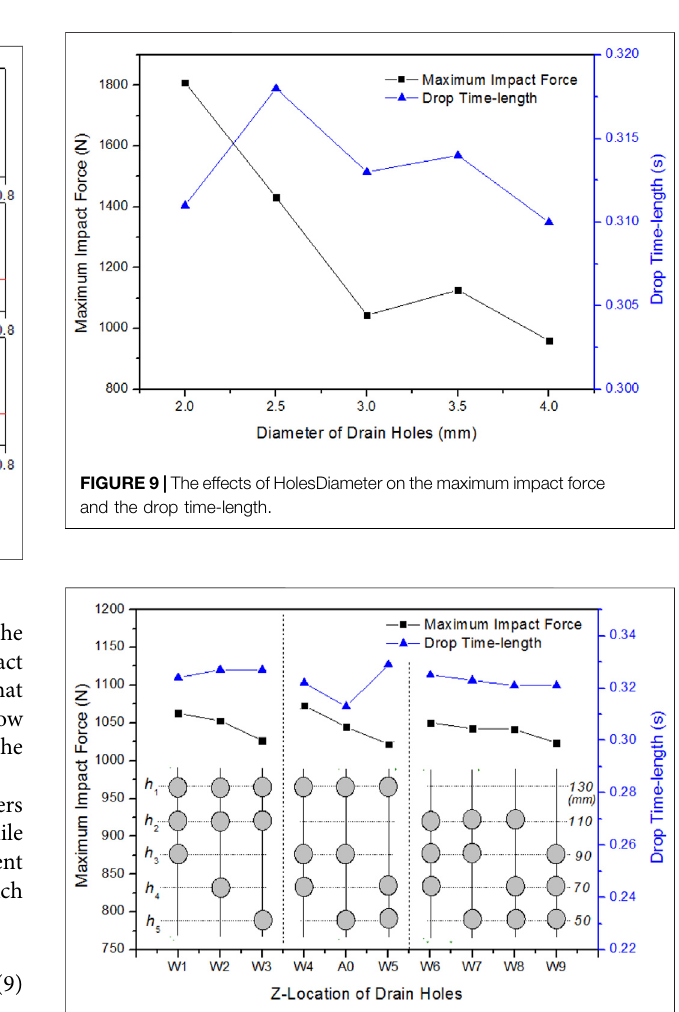
FIGURE 10 | The effects of hole location on the maximum impact force and the drop